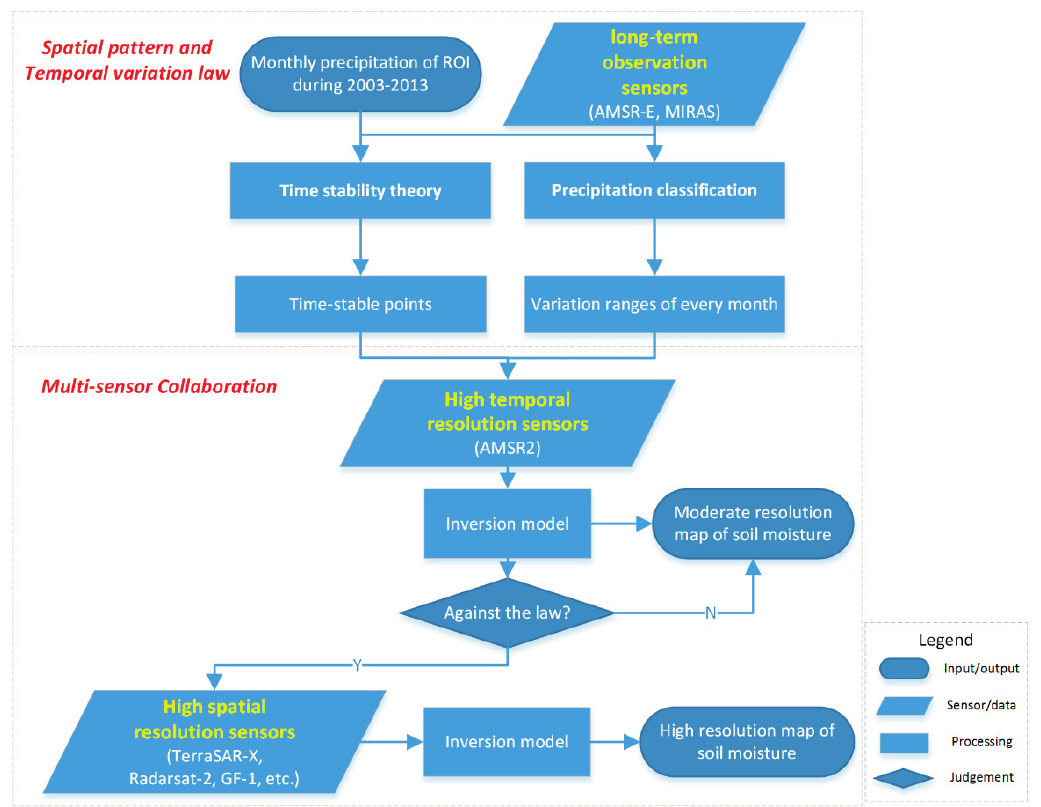
Figure 2. The flowchart of the proposed STMC method. The method is composed of two parts, the spatial pattern and temporal variation law extraction and the multi-sensor collaboration. Various remote sensors with different observation capabilities were orchestrated. These sensors included long-term observation sensors, high temporal resolution sensors, and high spatial resolution